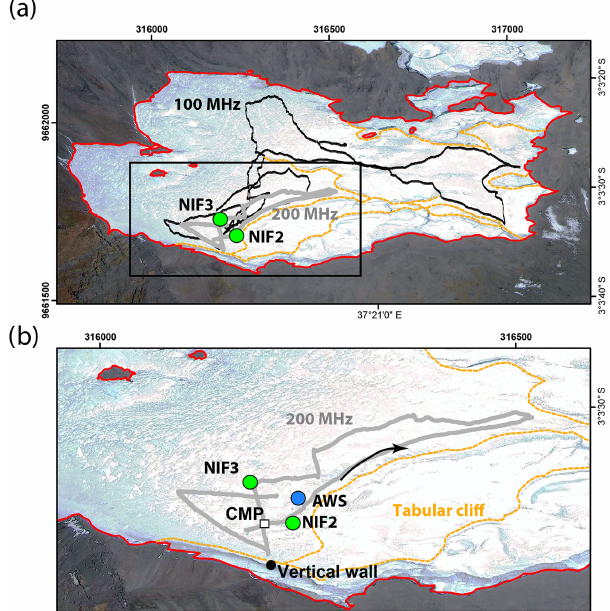
Figure 1. Spatial coverage of GPR common-offset profiles. Shown in (a) are all 100 and 200MHz profiles in black and grey lines, re- spectively. The zoomed-in window (b) (corresponding to the black rectangle in a ) shows the 200MHz profiles only. The black arrow indicates the approximate position of the two profiles compared in Fig. 2. Orange dashed lines highlight the tabular cliffs of NIF. Co- ordinates are in UTM